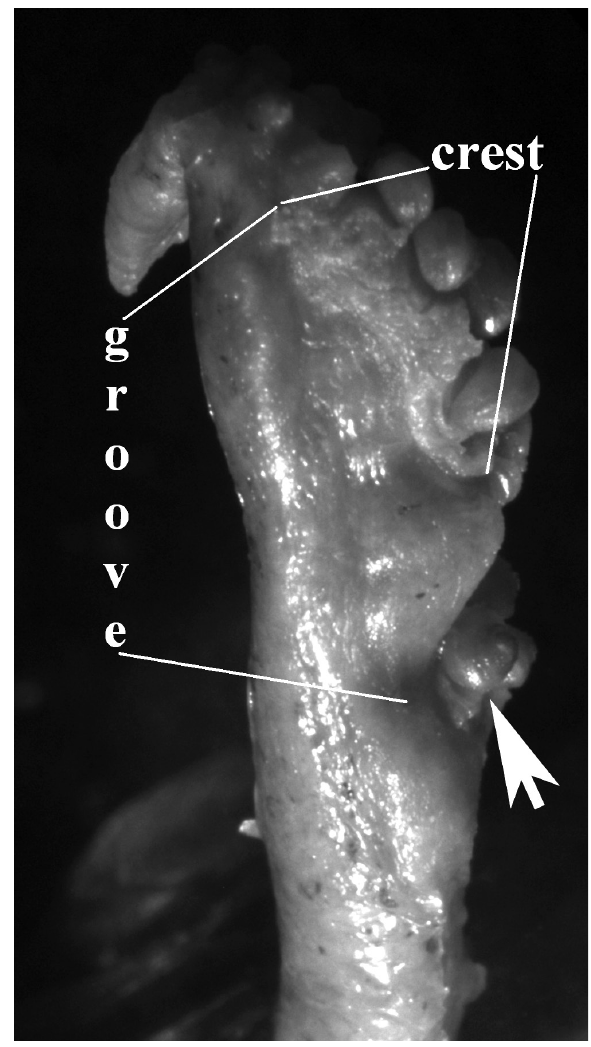
Fig . 9. – Inner lateral view of the hectocotylus of Sepiola bursad- haesa n. sp., paratype, MNCN 15.06/226P9, male. The span of the lateral groove and that of the crest bordering it orally are indicated; an arrow points to the dorsal basal sucker. (Distally the arm is artifi- cially bent at the level of the semi-circular groove perpendicular to the arm axis; see Fig.